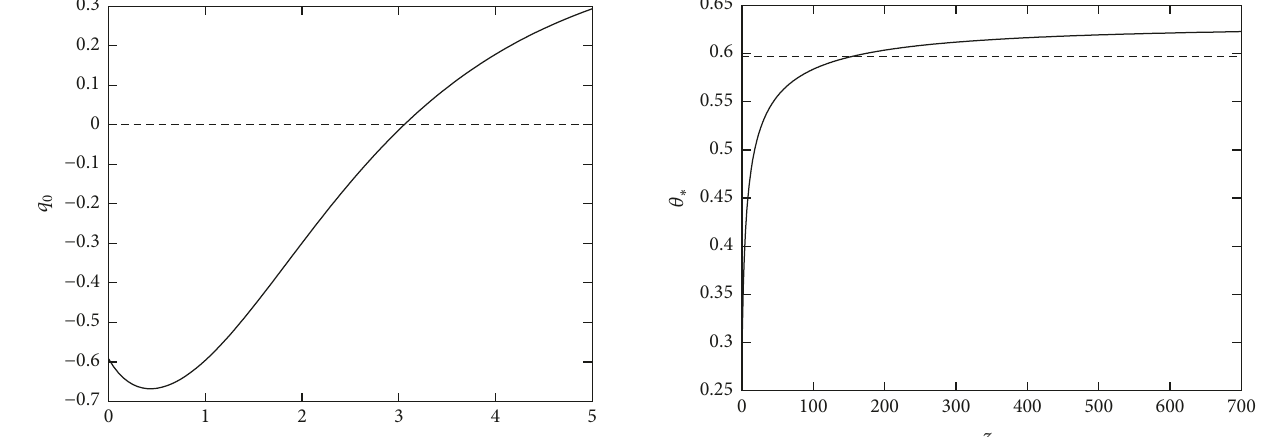
sound horizon at CMB photon decoupling, occurring at 𝑧